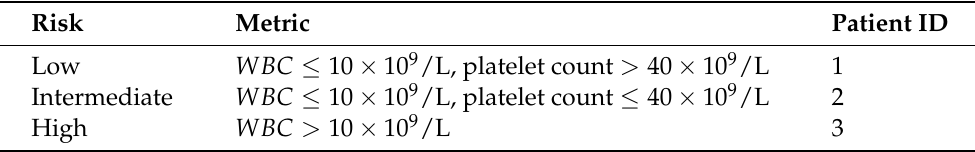
Table 11. The APL risk